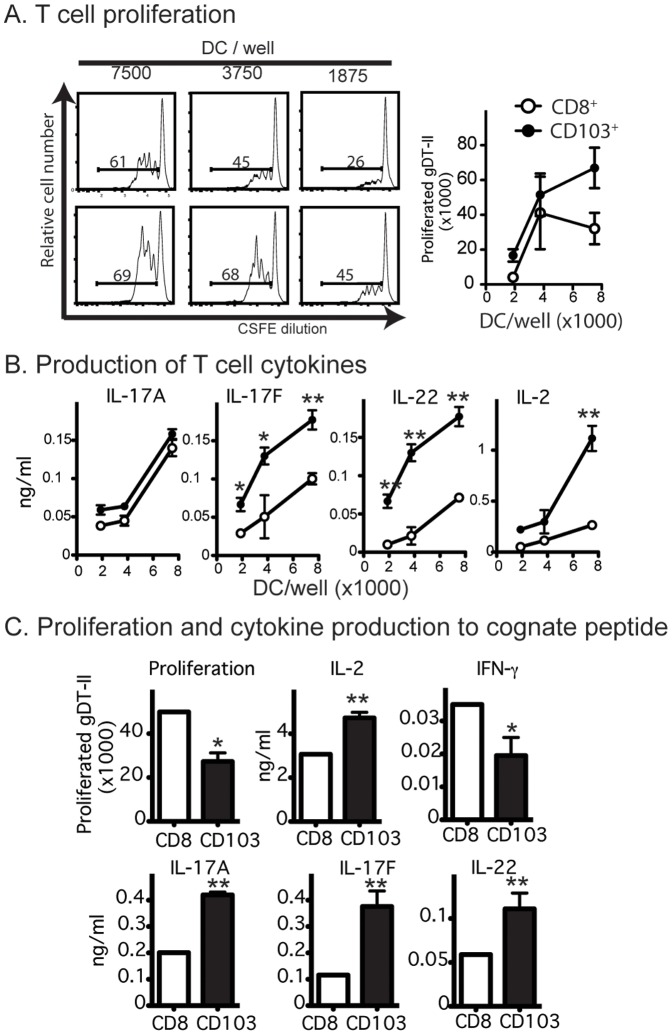
CD103+ DCs and CD8+ DCs have differential capacity to induce Th17 upon viral infection.(A) Proliferation of 5×104 CFSE-labeled HSV-specific CD4+ T cells (gDT-II) after 60 h of culture together with serial dilutions of DC subsets isolated from brachial lymph nodes of mice infected withn HSV 5 d earlier. (B) Culture supernatants from (A) were measured for the indicated cytokines. (C) Proliferation and cytokine production with isolated DCs and exogenous source of antigenic peptide. Data (mean ± SEM) are one of two individual experiments. (**P<0.01; Two tailed Student's T test).